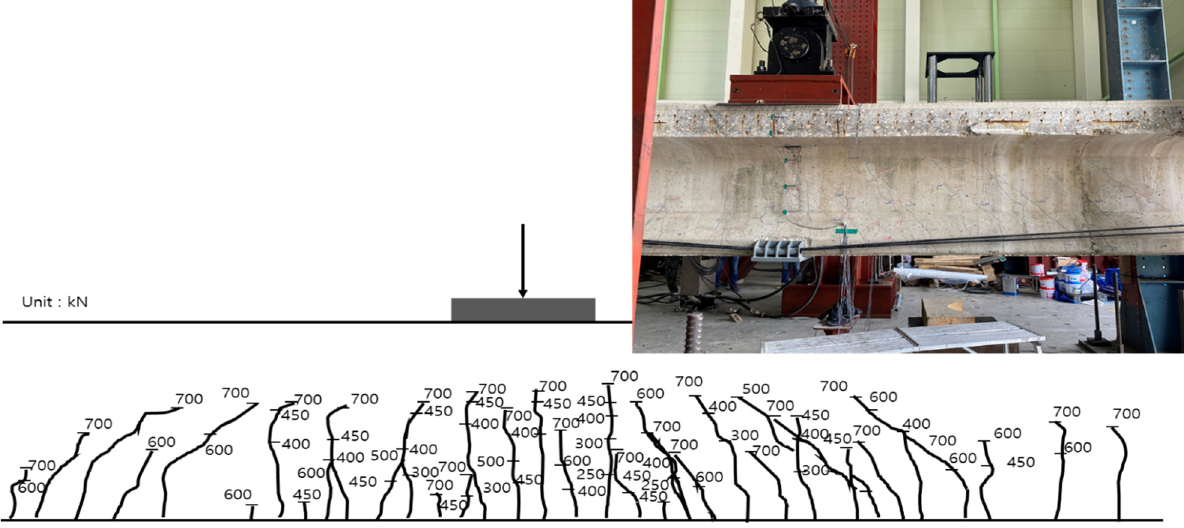
Figure 18. Crack map according to the load after reinforcement using the EP method.